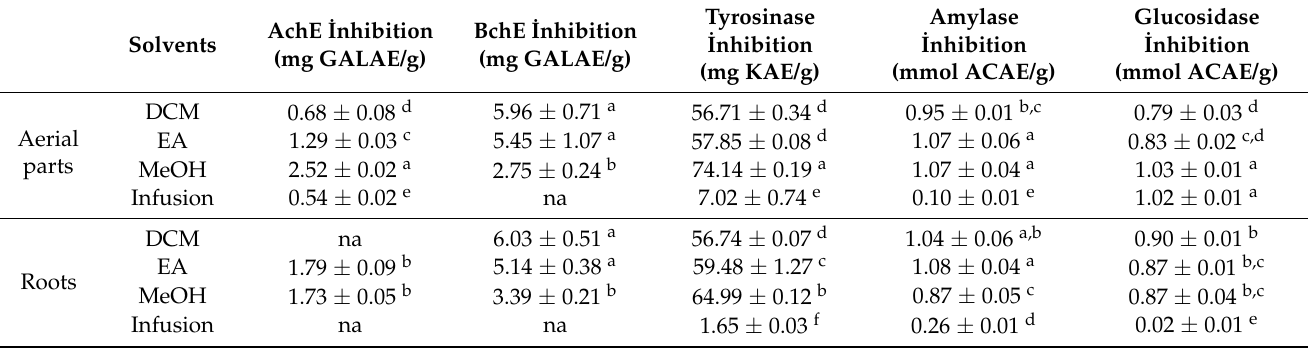
Table 7. Enzyme inhibition properties of Sartoria hedysaroides extracts